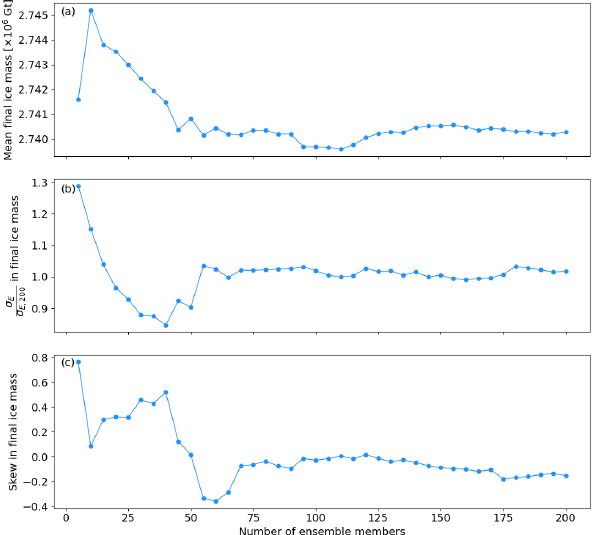
Figure C3. Convergence of the (a) mean, (b) standard deviation, and (c) skew in final ice mass for the GrIS transient ensemble as a function of number of ensemble members. For (b) , we show the standard deviation relative to the standard deviation of the full en- semble with 200